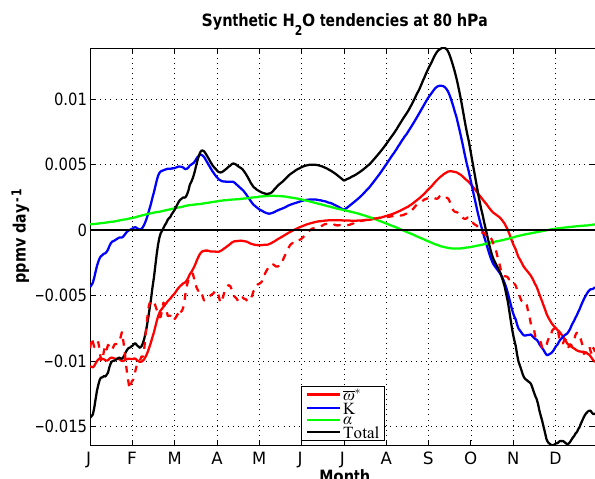
Figure 7. The contributions to the water vapor tendency (ppmvday − 1 ) at 80hPa from the best synthetic 1-D transport model solution for MLS ( a = c = 1, b = 4; corresponding to the white star in the left panel of Fig. 5). The red dashed line shows the tendency due to the vertical residual velocity from